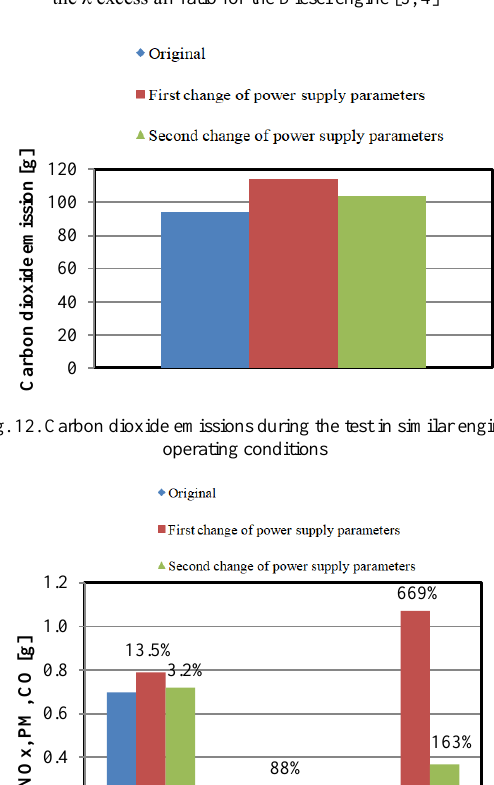
Fig. 11. Dependence of CO, HC, NO x , D B opacity of particulate matter on the λ excess air ratio for the Diesel engine [3, 4]